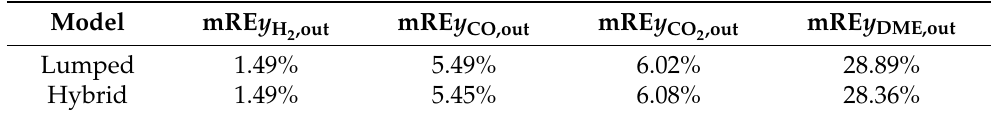
Table 3. Mean relative errors (mRE) between the experiments and the predictions of the lumped and hybrid